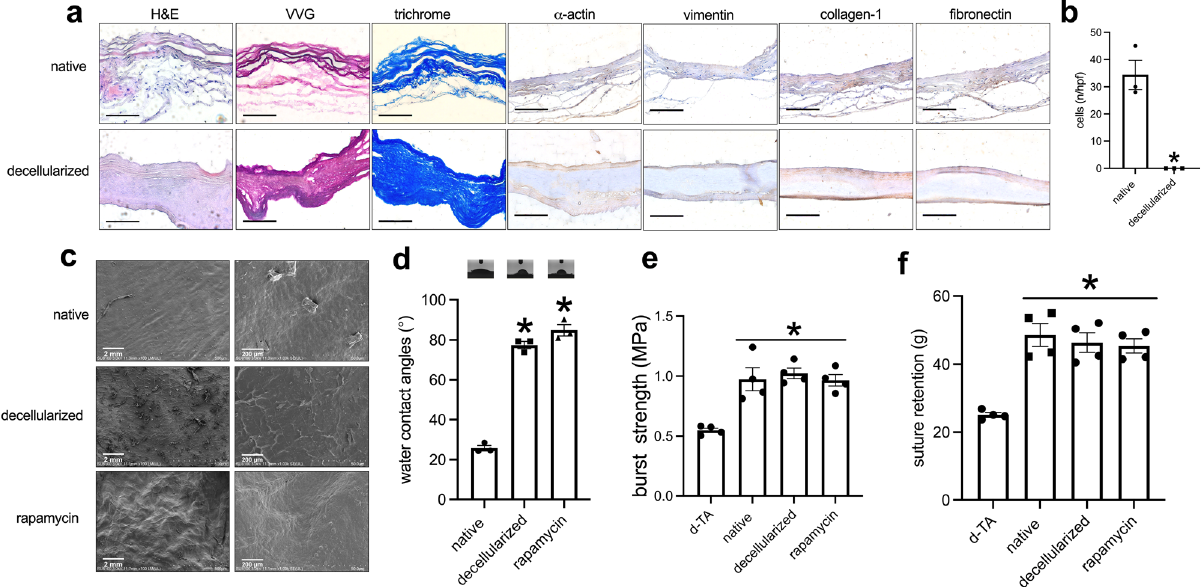
Fig. 2 Comparison of the fresh and decellularized fi sh swim bladder. a Photographs showing the swim bladder before and after decellularization, stained with hematoxylin & eosin, VVG, trichrome, α -actin, collagen-1, fi bronectin, or vimentin; scale bar, 100 μ m; n = 3. b Bar graph showing the cell number before and after decellularization, * p = 0.0031, t -test; n = 3. c SEM images of fresh, decellularized and rapamycin-coated patches (rapa-coating); scale bar, 200 μ m; n = 3. d Water contact angles of fresh, decellularized and rapamycin-coated patches; the inset panels showing the photographs of the water contact angles; p < 0.0001, one-way ANOVA; * p < 0.0001, Tukey ’ s multiple comparisons test; n = 3. e Bar graph showing the burst test, * p = 0.0003, one- way ANOVA; d-TA, decellularized rat thoracic aorta; n = 4. f Bar graph showing the suture retention, * p = <0.0001, one-way ANOVA; d-TA, decellularized rat thoracic aorta; n = 4. Data are expressed as mean ±